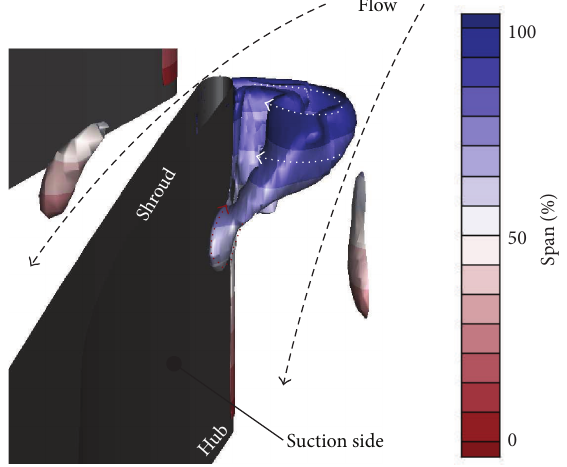
Figure 13: Instantaneous isosurface of the negative 𝜆 2 vortex criterion.